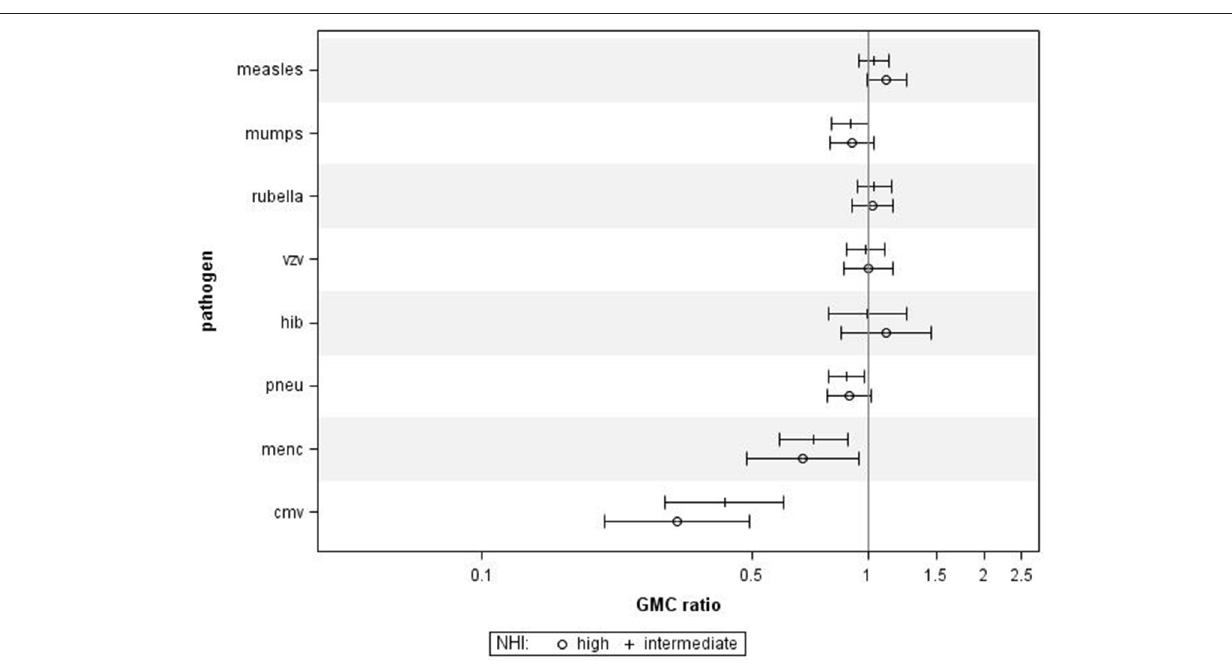
When combining all age groups, higher educational level was significantly associated with higher IgG against measles (GMC educational level, ( Figure 1 ). High educational level was not significantly associated with IgG levels against mumps,